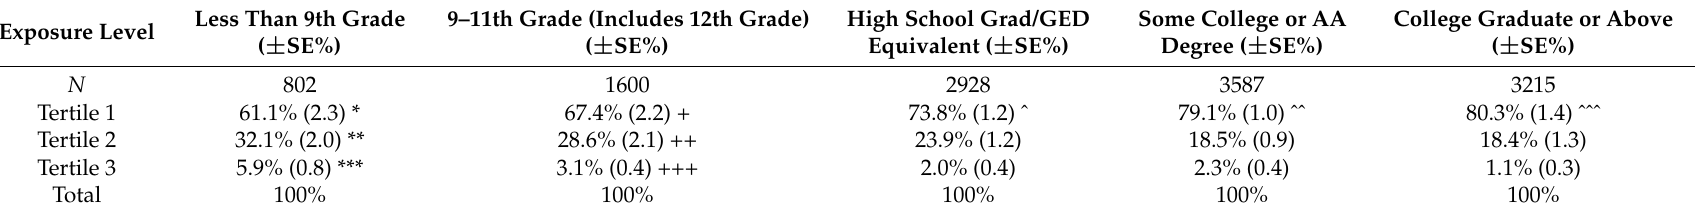
Table 2. Education Level and Tertiles of